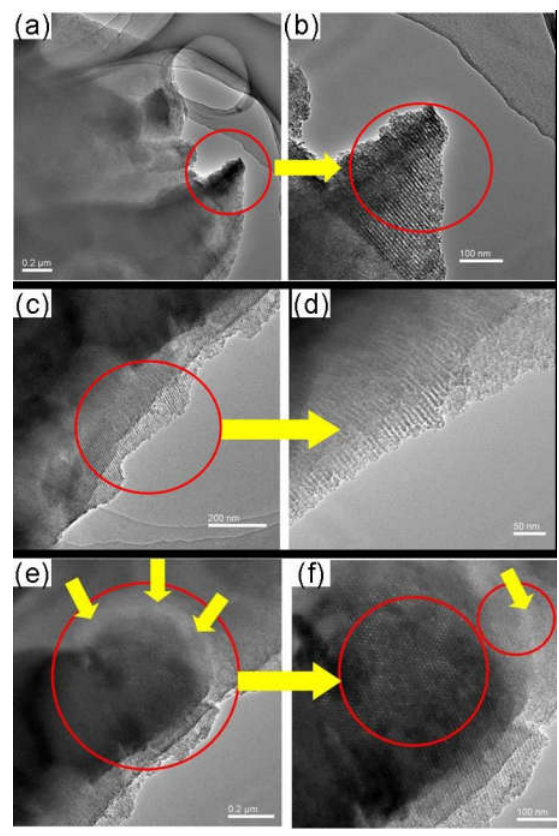
Figure 18. TEM images of the as-made SBA-15/C functional membranes [38].